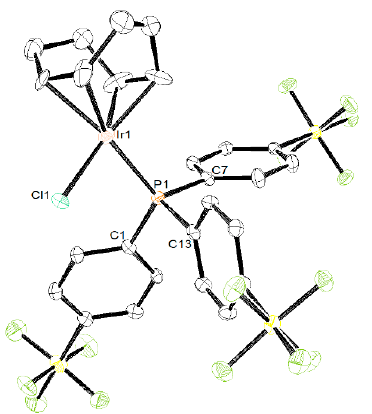
Figure 3. ORTEP representation of 4 with thermal ellipsoids drawn at 50% probability level. Hydrogen atoms and the additional C 6 H 6 molecule in the unit cell have been omitted for clarity. Note that some disorder is observed in COD ligand. Selected bond lengths [Å] and bond angles [deg]: Ir1–P1